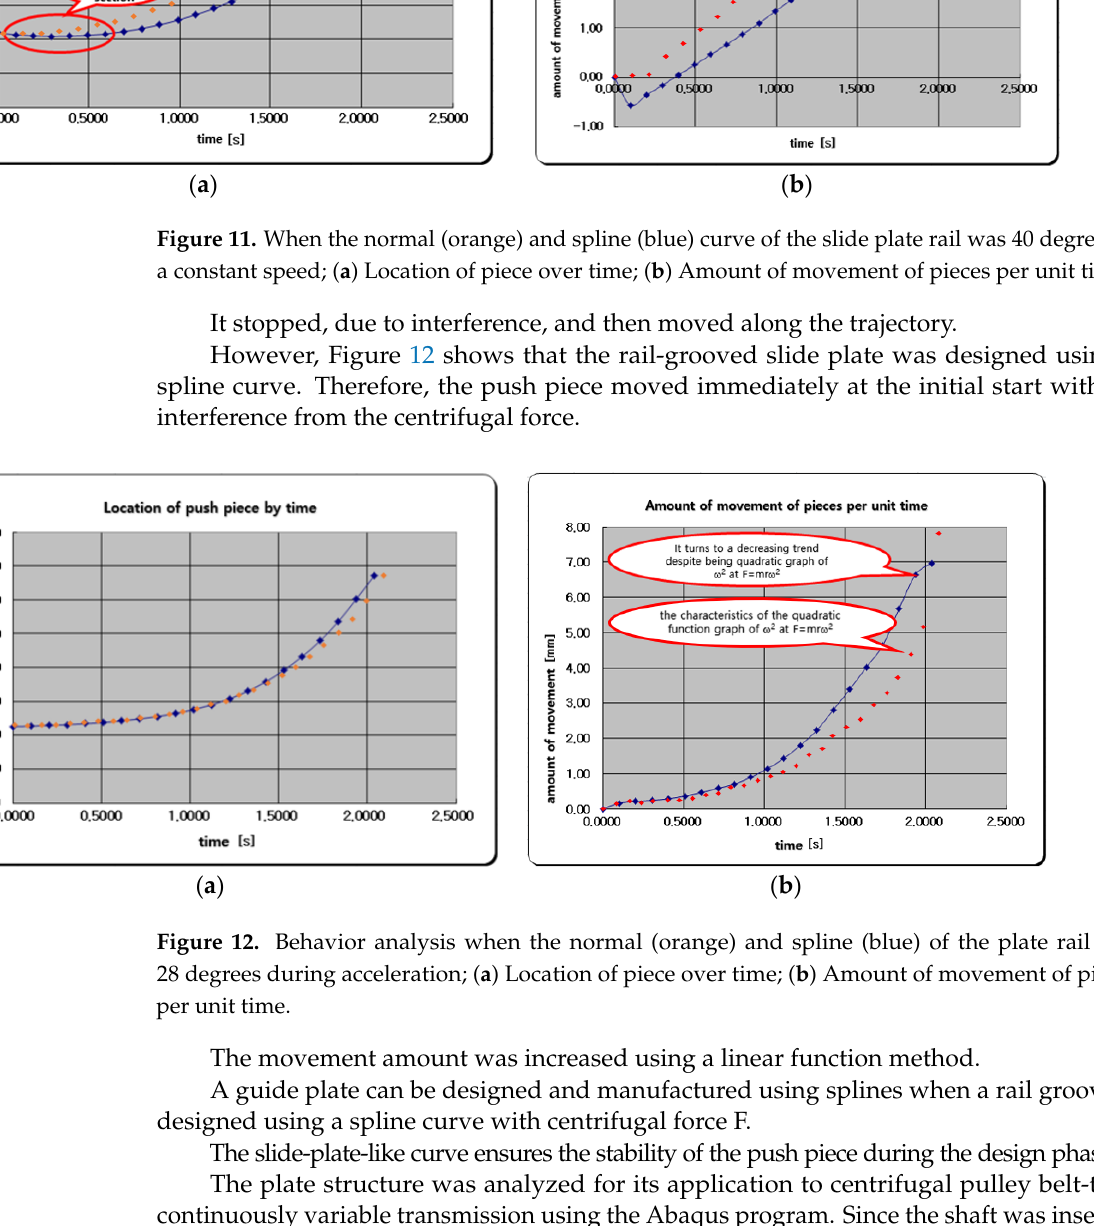
Figure 12. Behavior analysis when the normal (orange) and spline (blue) of the plate rail was 28 degrees during acceleration; ( a ) Location of piece over time; ( b ) Amount of movement of pieces per unit time.